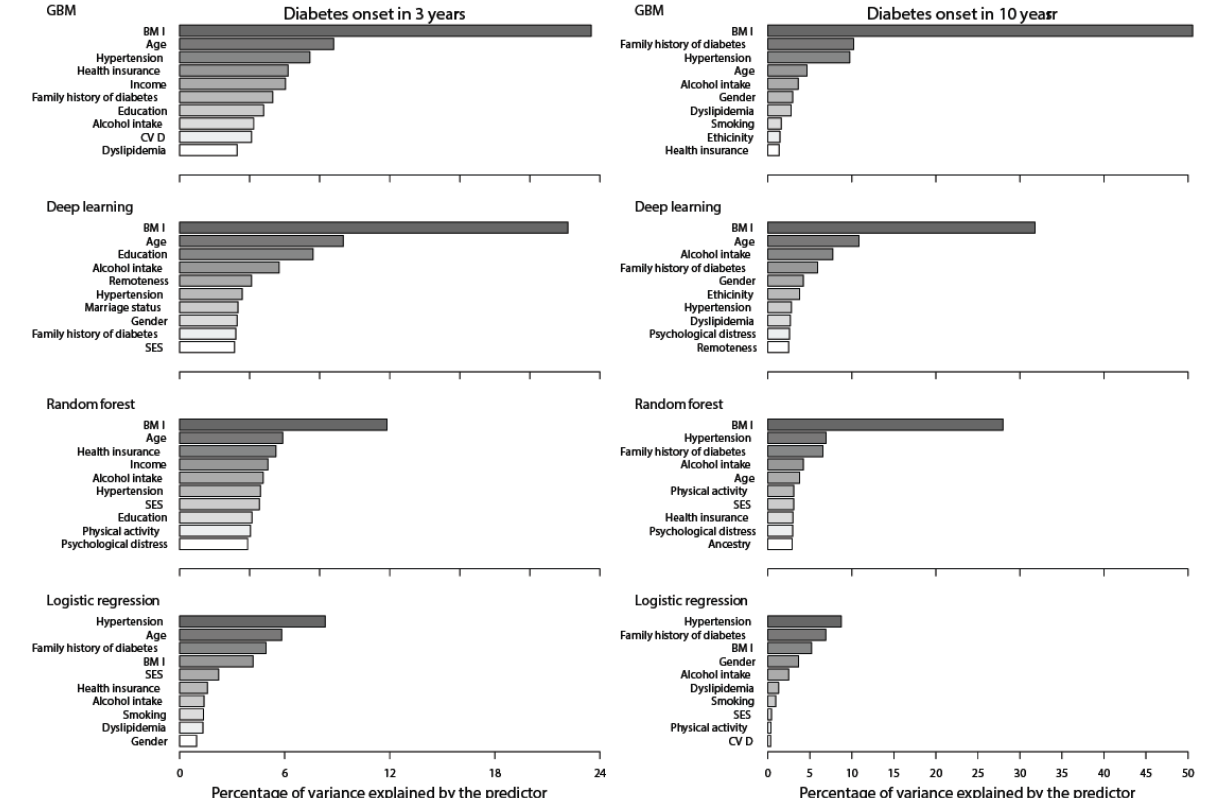
Figure 2. Ranked contribution to the variance of diabetes prediction by various models. (+ increasing risk; - decreasing risk; * being male increases risk compared with being female; # being born overseas increases diabetes risk compared with being born in Australia; § having private insurance decreases risk compared with having no private insurance; $ being in major cities increases risk compared with being in inner or outside regional areas; ‡ having Asian or other ancestry increases diabetes risk compared with having Australian ancestry). GBM: gradient boost